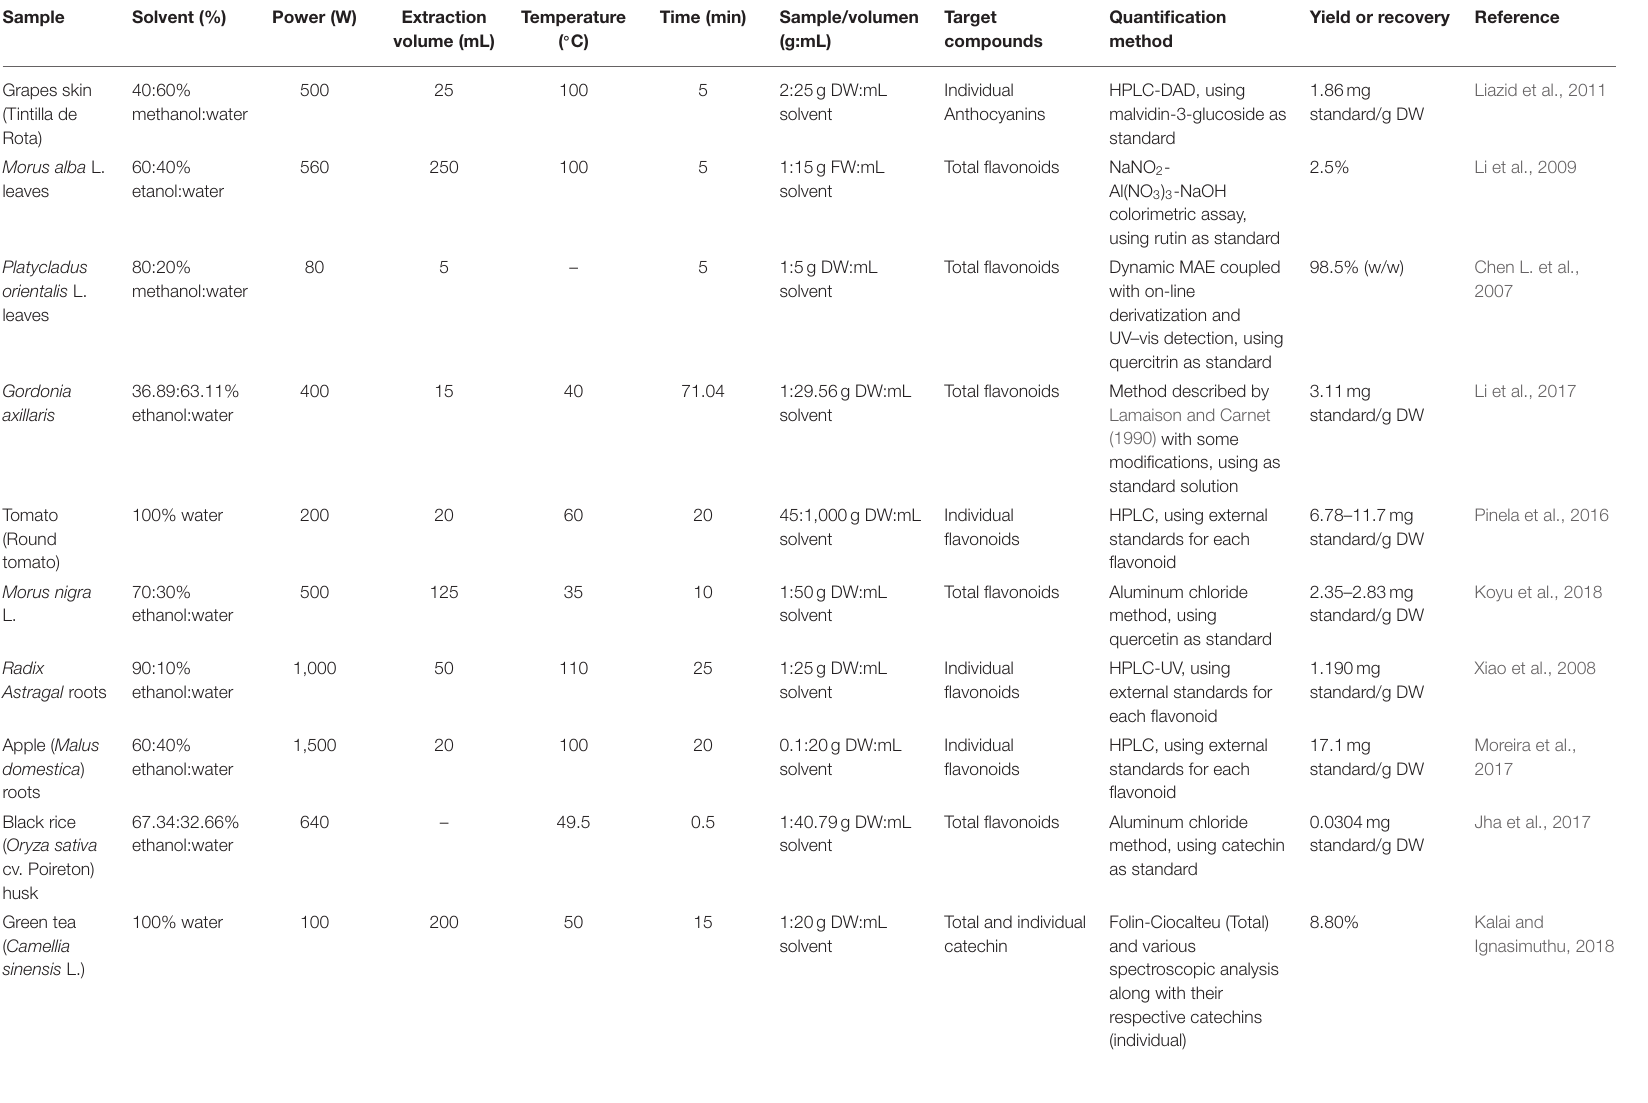
TABLE 3 | Some representative applications involving the use of MAE for the recovery of flavonoids from natural sources.